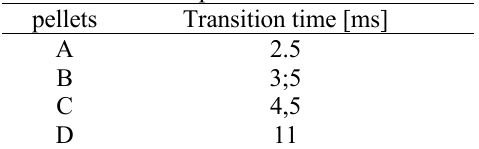
Figure 7: The variation of the J / Jc ratio for the different superconducting pellets A, B, C and D as a function of time with Jc = 9 × 107 A / m2